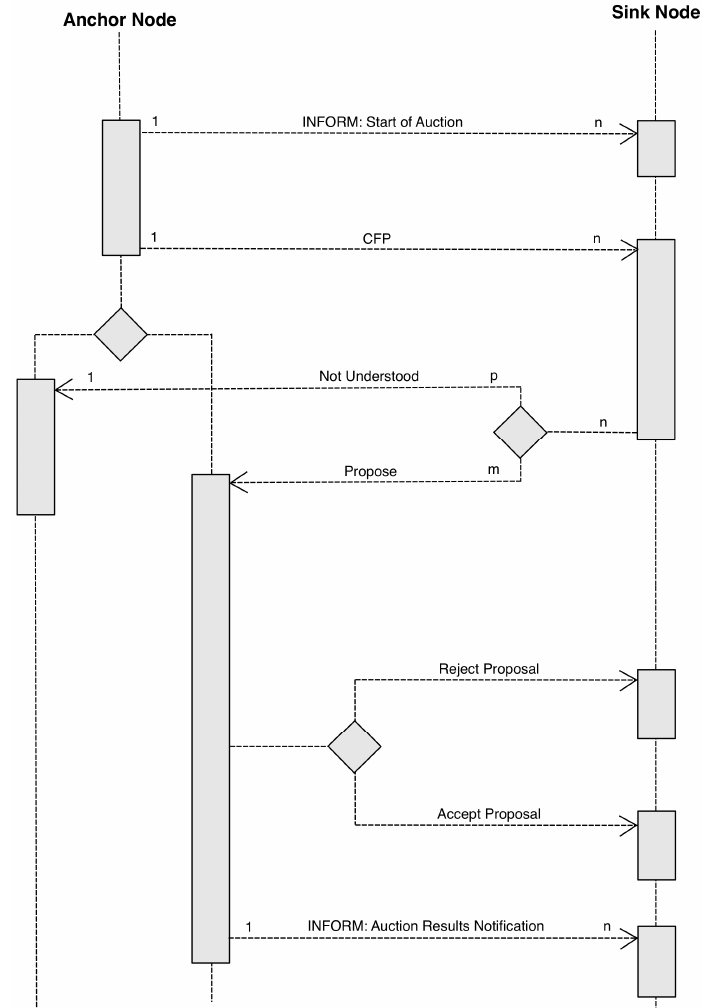
Figure A2. Agent interaction diagram showing distributed cluster formation using the dynamic technique.